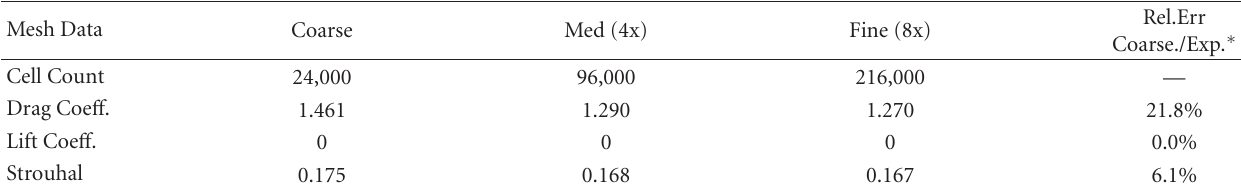
Table 1: Summary of mesh study parameters.